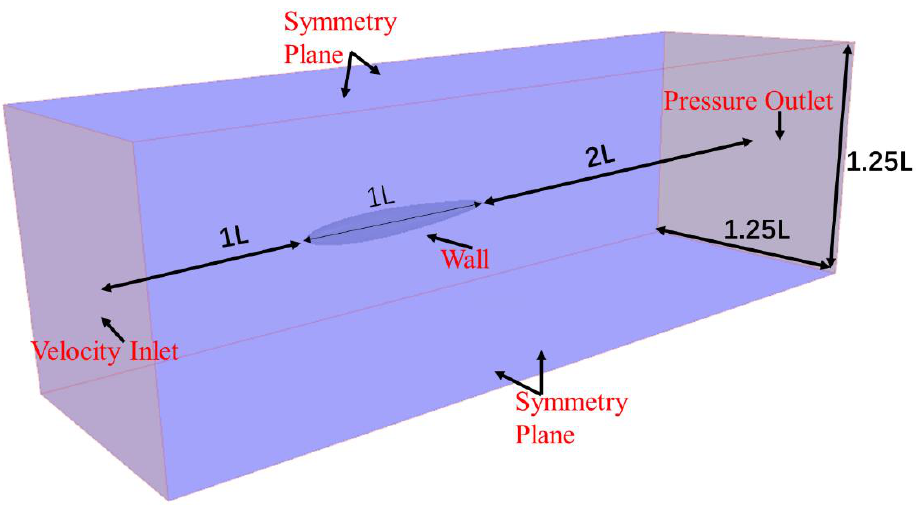
Figure 2. Fluid domain and boundary conditions.